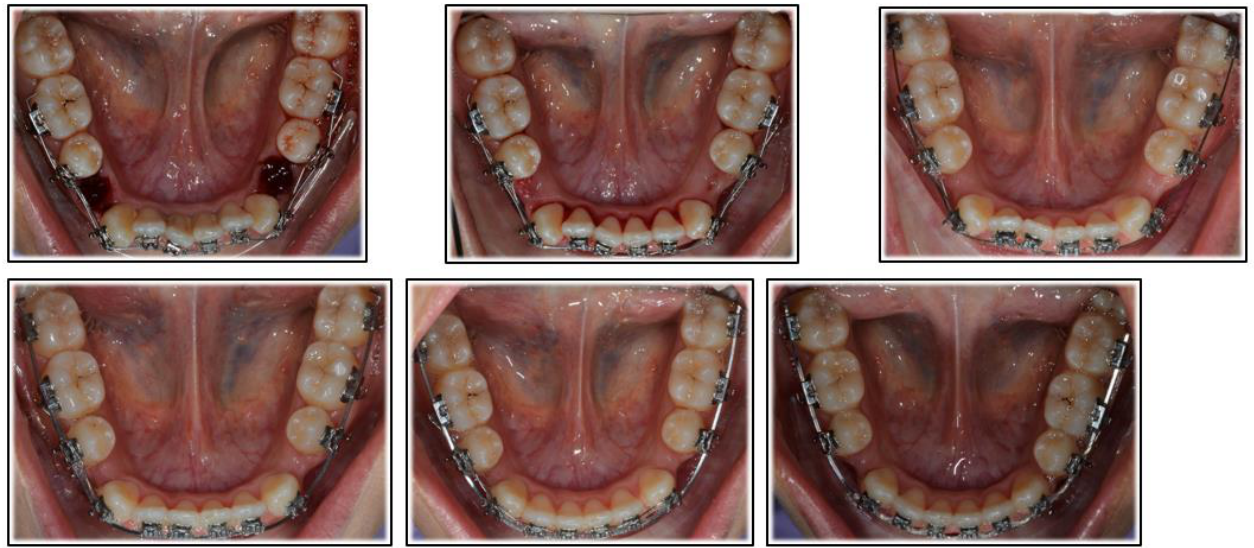
Figure 3. Alignment and leveling phases with 0.16 CuNiTi and 19 × 25 CuNiTi.